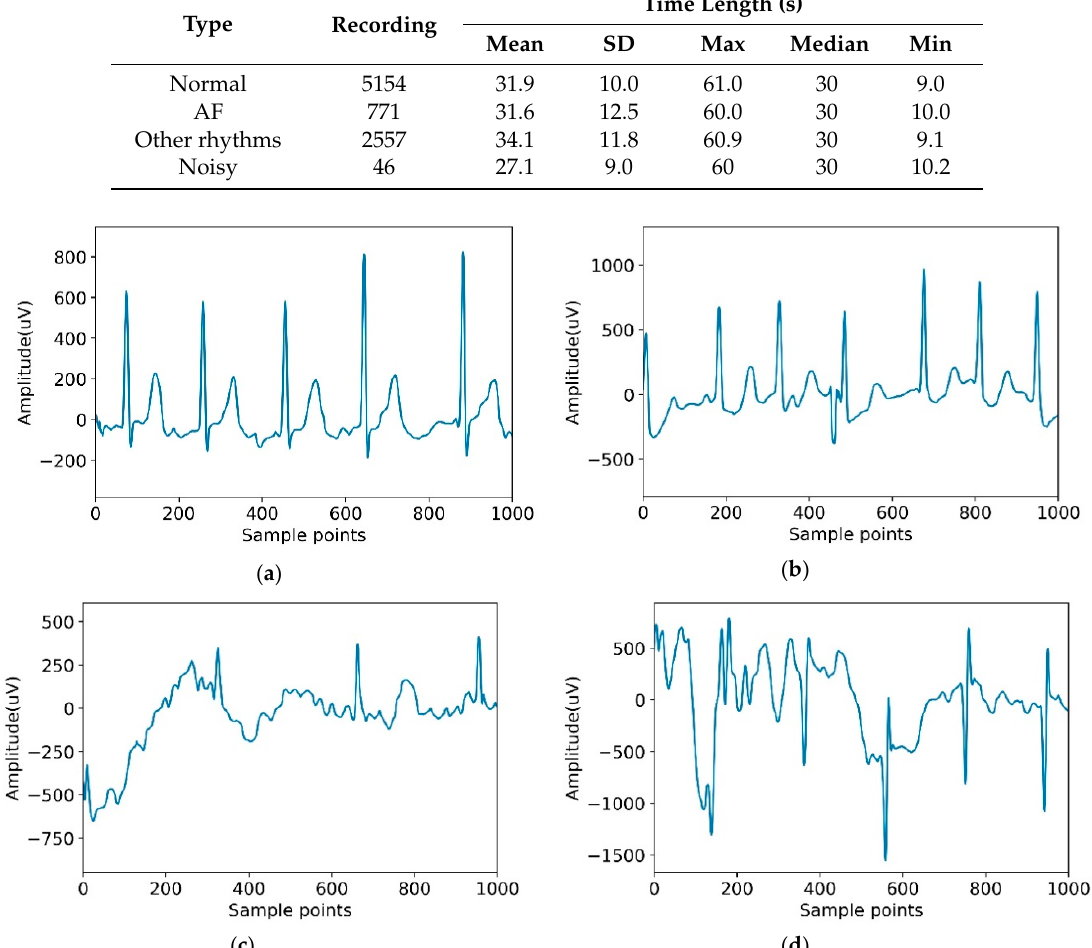
Figure 4. Typical recordings for each of the four classes in the dataset. ( a ) Normal; ( b ) Atrial fibrillation (AF); ( c ) Other; ( d ) Noisy. Table 2. The distribution of datasets.